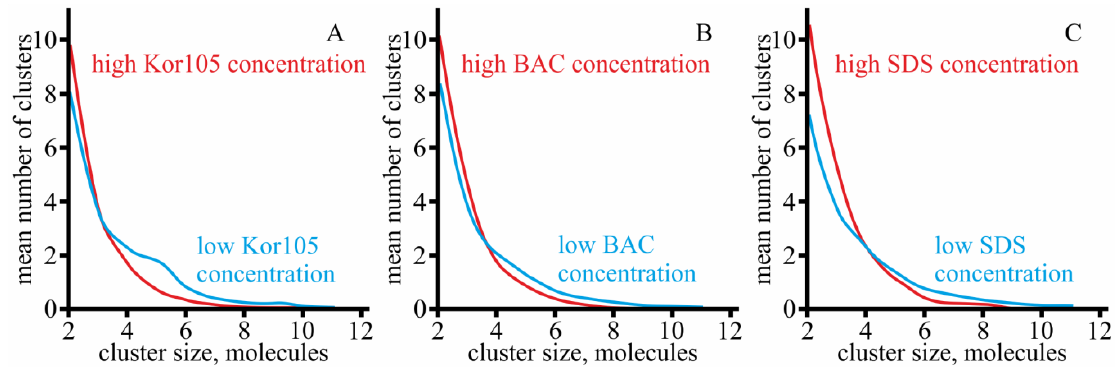
Figure 9. Size distribution of cholesterol clusters for A —Kor105 ion, lowKorCholDOPC, and highKorCholDOPC systems; B —BAC ion, lowBacCholDOPC, and highBacCholDOPC systems; and C —SDS ion, lowSDSCholDOPC, and highSDSCholDOPC systems. Blue curves—low concentration of the ion; red curves—high concentration of the ion.